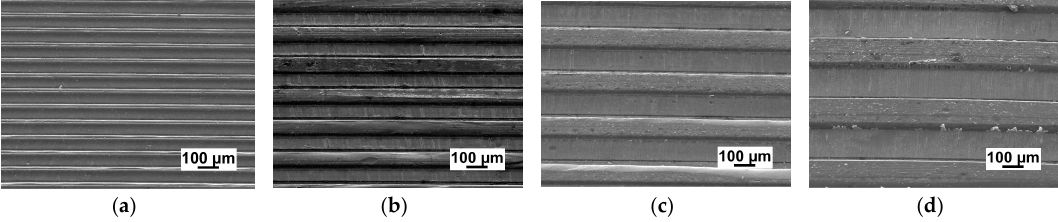
Figure 8. SEM images of micro-array channels with different width: ( a ) 50 µ m; ( b ) 100 µ m; ( c ) 150 µ m; ( d ) 200 µ